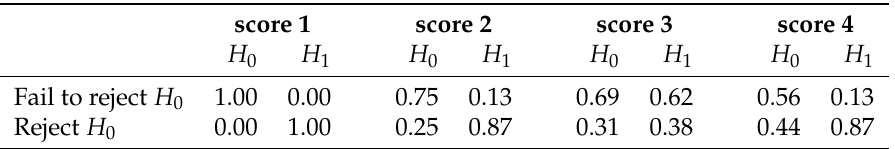
Table 8. Sensitivity and specificity of the test for each of the four scores when the size of the samples to diagnose is ν = 50.